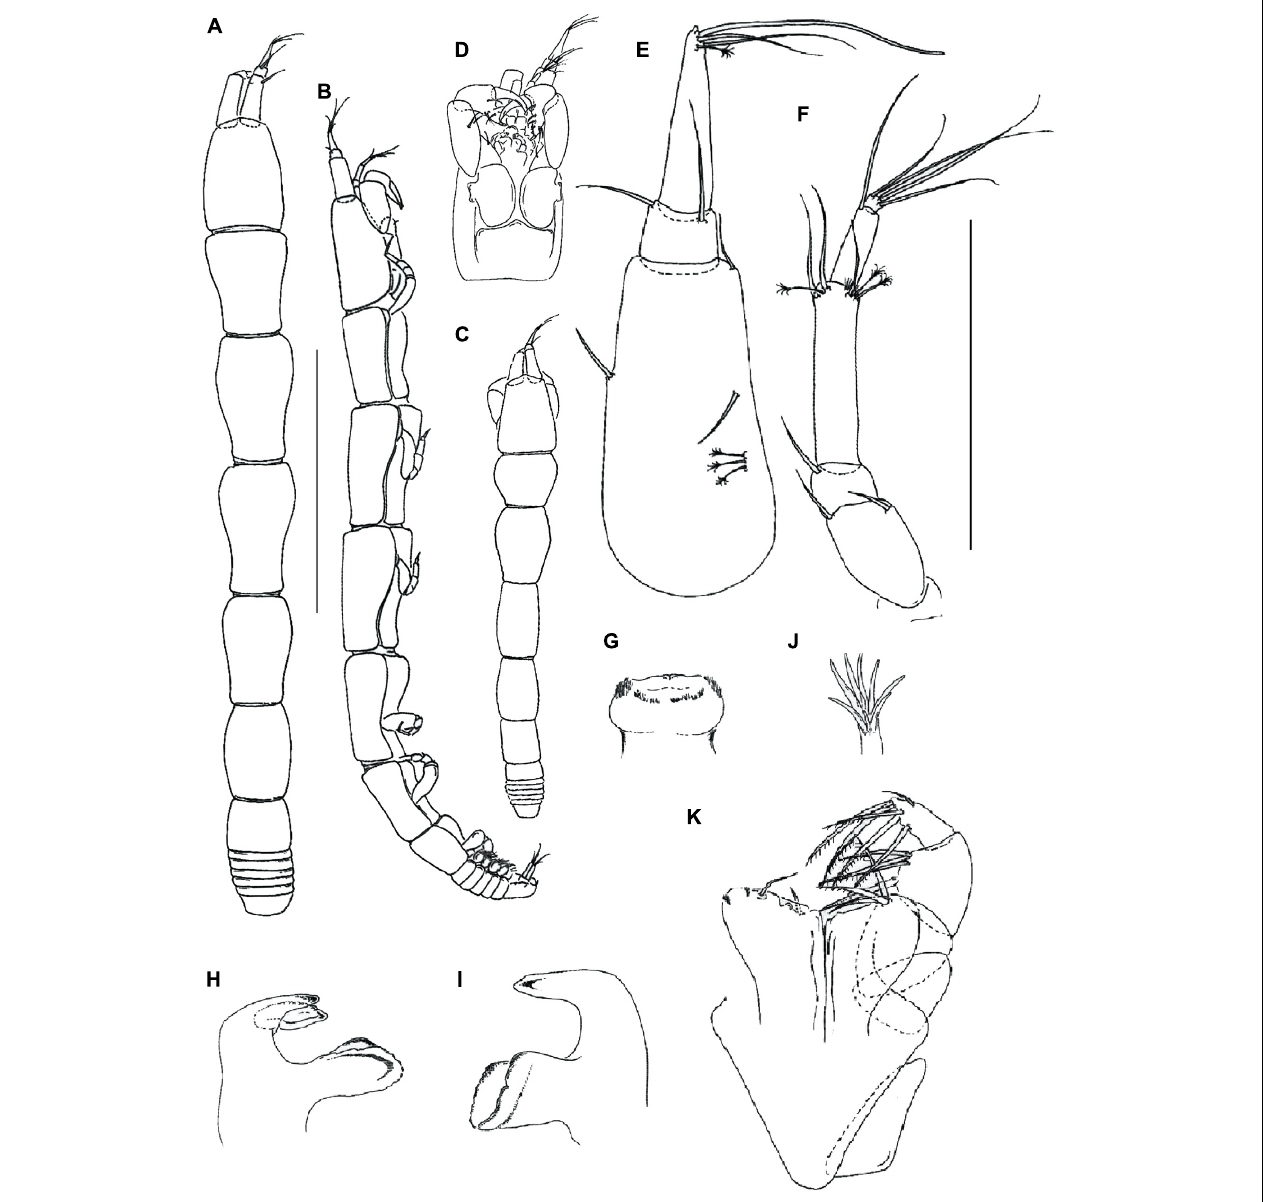
FIGURE 2 | Hamatipeda caipirinha n. sp. (MCZ 48366) (A,B) neuter; (C) manca-3; morphological details: (D) cephalothorax ventral side; (E) antennule; (F) antenna; (G) , labrum; (H,I) , mandible left and right, respectively; (J) , maxillule endite tip; (K) , maxilliped and maxilla. Scale: panels (A,B) = 1 mm, panels (E–K) = 0.1